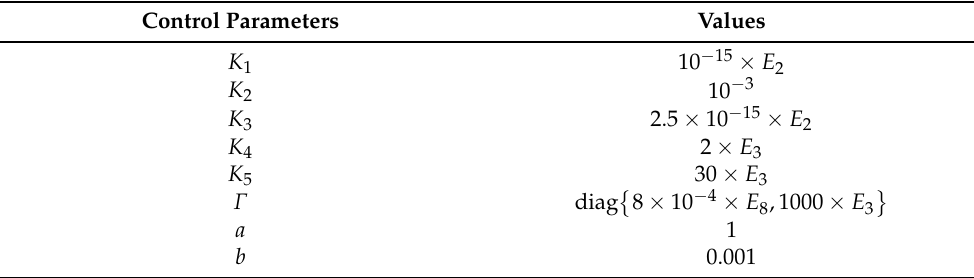
Table 6. Image-based control parameters. Control Parameters